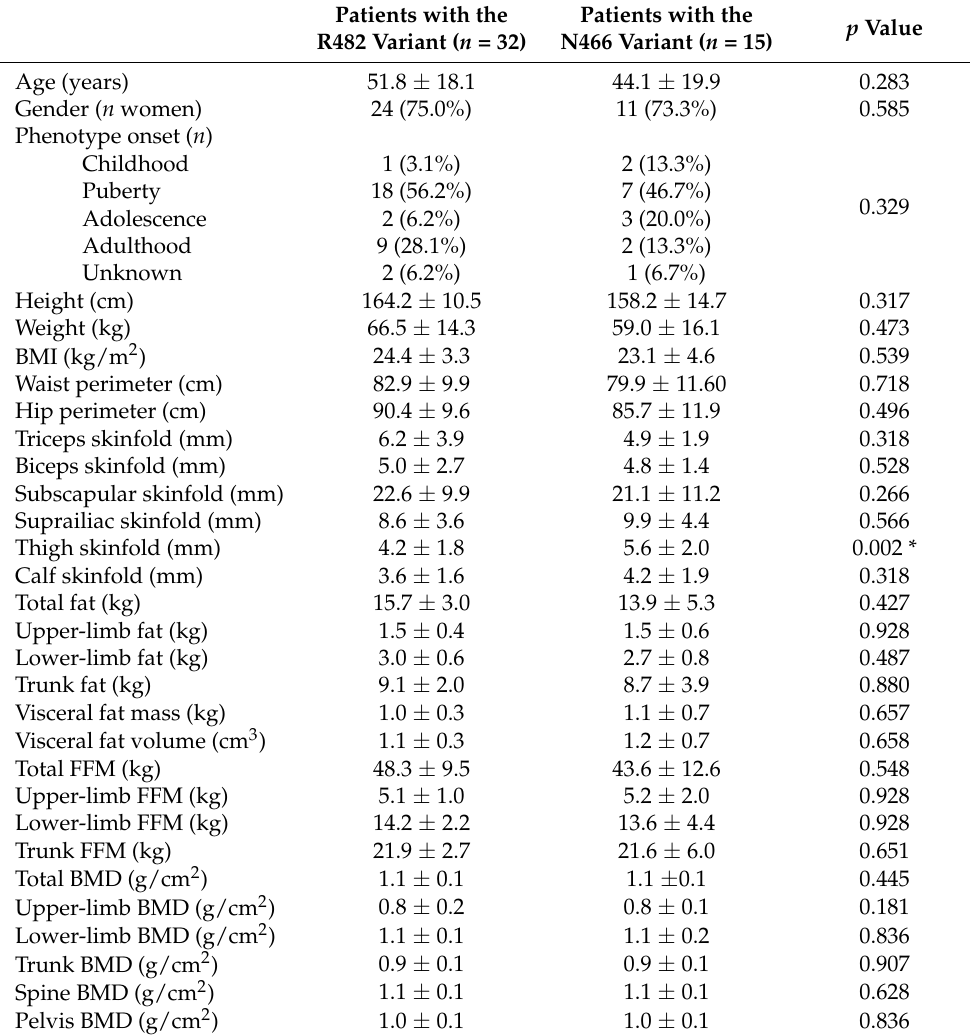
Table 2. Demographic data, anthropometric measurements, and body composition determined by dual-energy X-ray absorptiometry (DXA) in FPLD2 patients depending on the variant in exon 8 of the LMNA gene. Patients with the Patients with the p R482 Variant ( n = 32) N466 Variant ( n = 15)